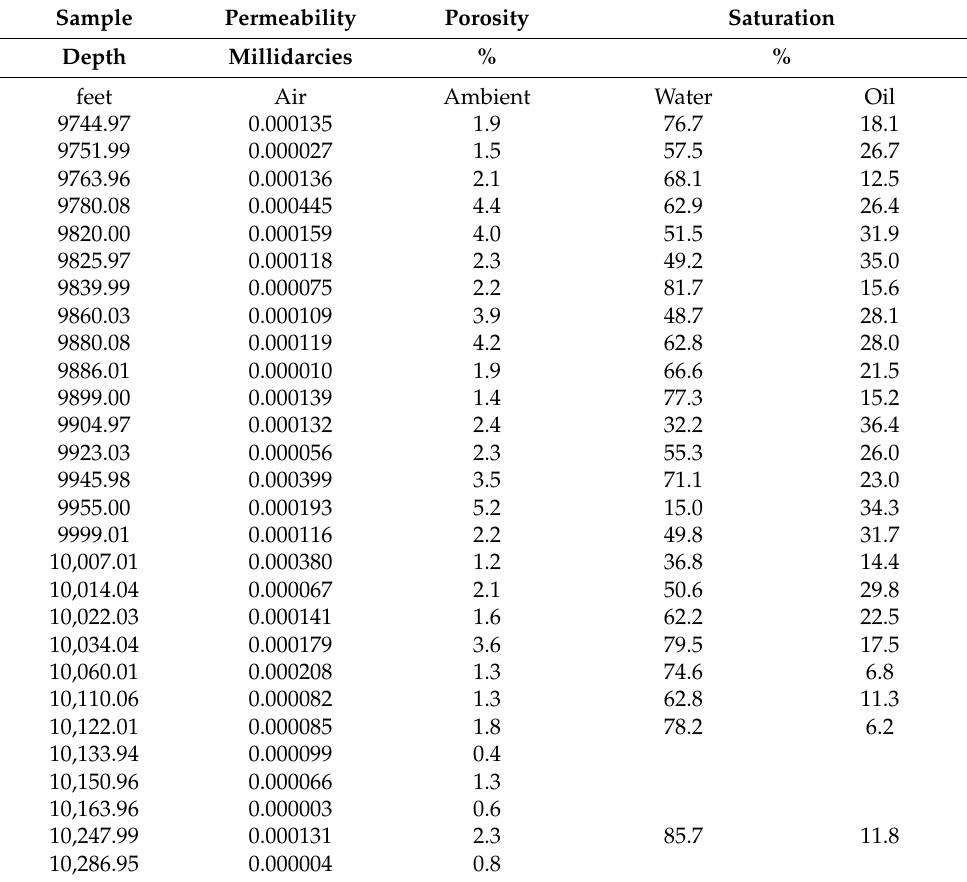
Table A1. Measure cores rock